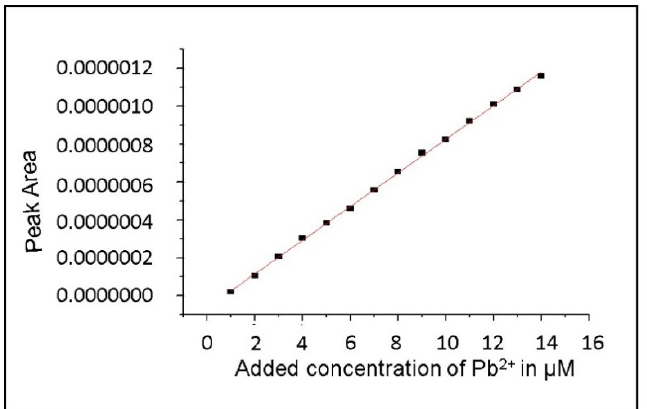
Figure 2. Standard addition plot of peak area from Figure 1 against added Pb 2+ ion concentration (1–14 µM).